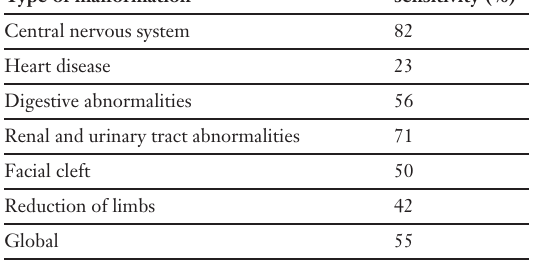
Sensitivity of screen- ing in the tertiary centre, in private practice and in regional hospitals.